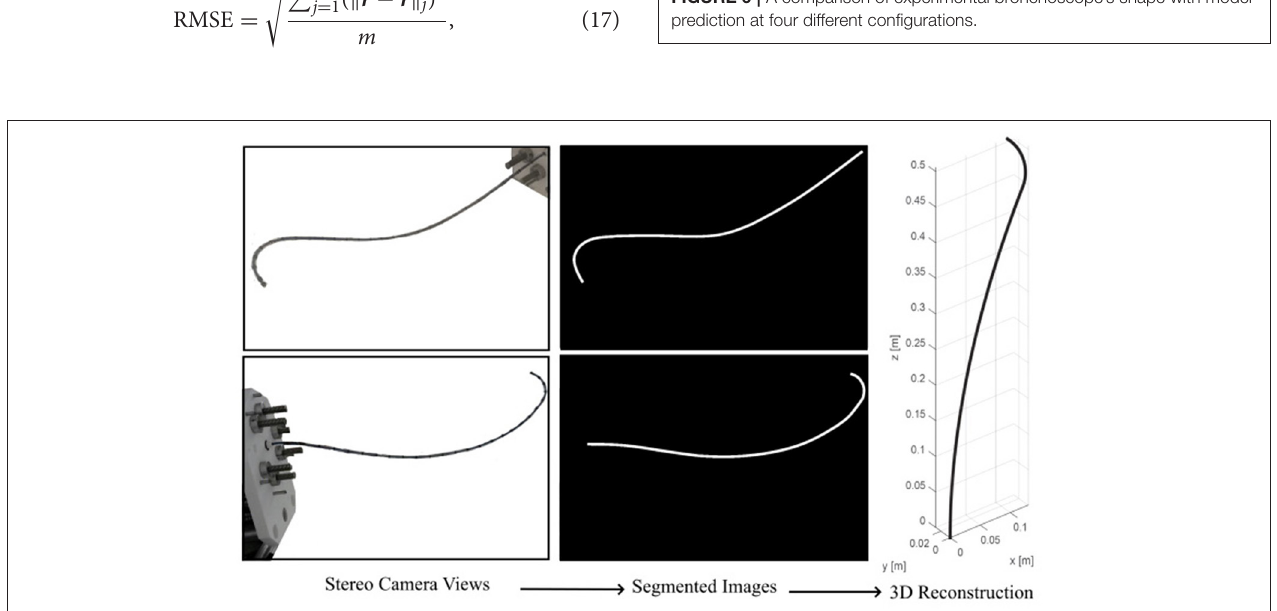
FIGURE 5 | Estimating robot’s backbone shape using two calibrated cameras.